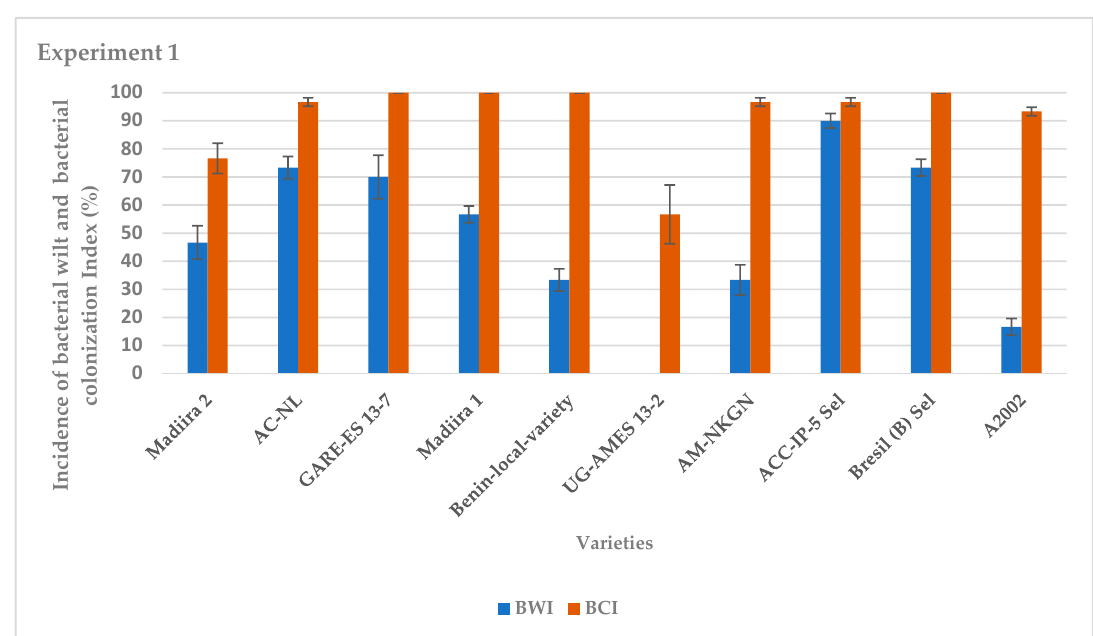
Figure 1. Incidence of bacterial wilt (IBW) and bacterial colonization index (BCI) during experiment 1 in the screen house. Error bars indicate the standard error of mean (S.E.M).